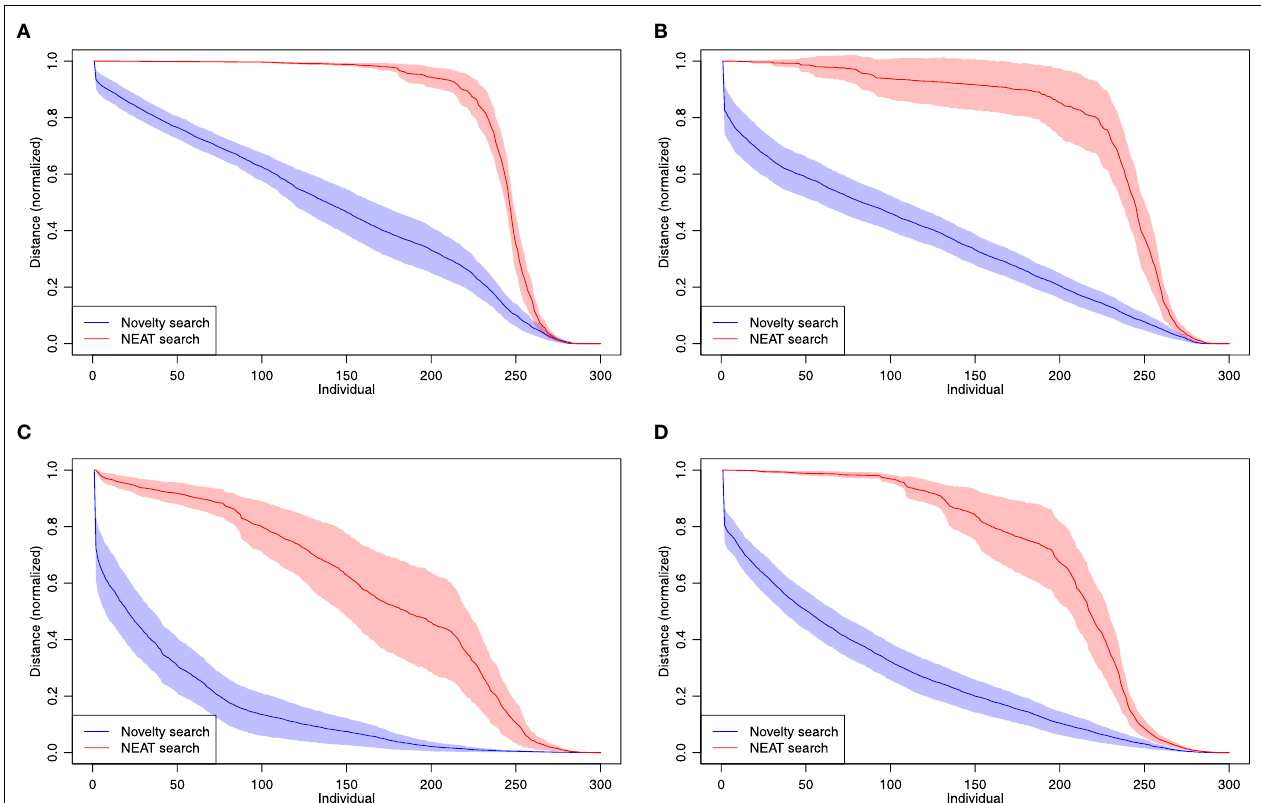
FIGURE 11 | Normalized fitness distributions in populations at generation 2000 collected from 20 independent evolutionary runs of each of the four experiment types . (A) Aquatic environment (oscillator-driven actuation), (B) aquatic environment (GRN-driven actuation), (C) terrestrial environment (oscillator-driven actuation), (D) terrestrial environment (GRN-driven